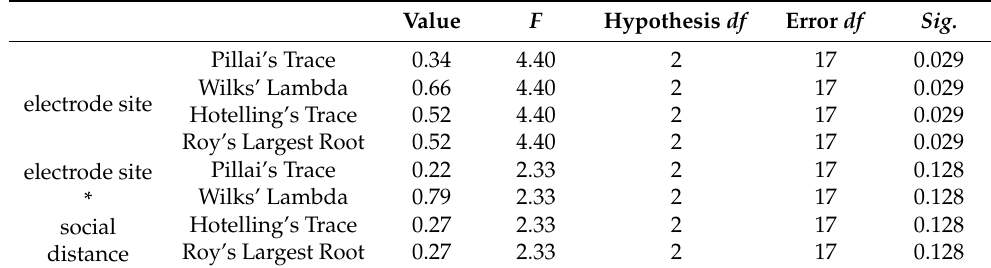
Table 6. Multivariate tests of N1 amplitude (promotion focus).